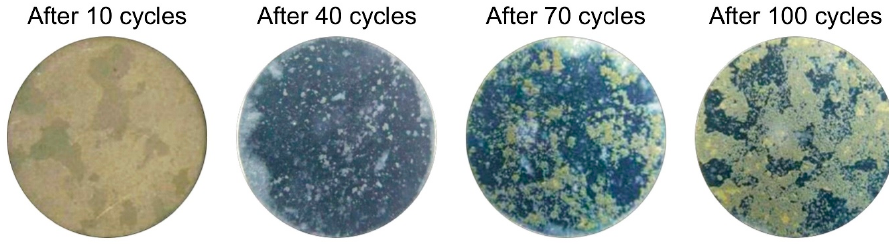
Figure 12. The outer surface of the aluminized Ti–45Al–8Nb–0.5(B, C) alloy after cyclic isothermal oxidation at 950 °C.